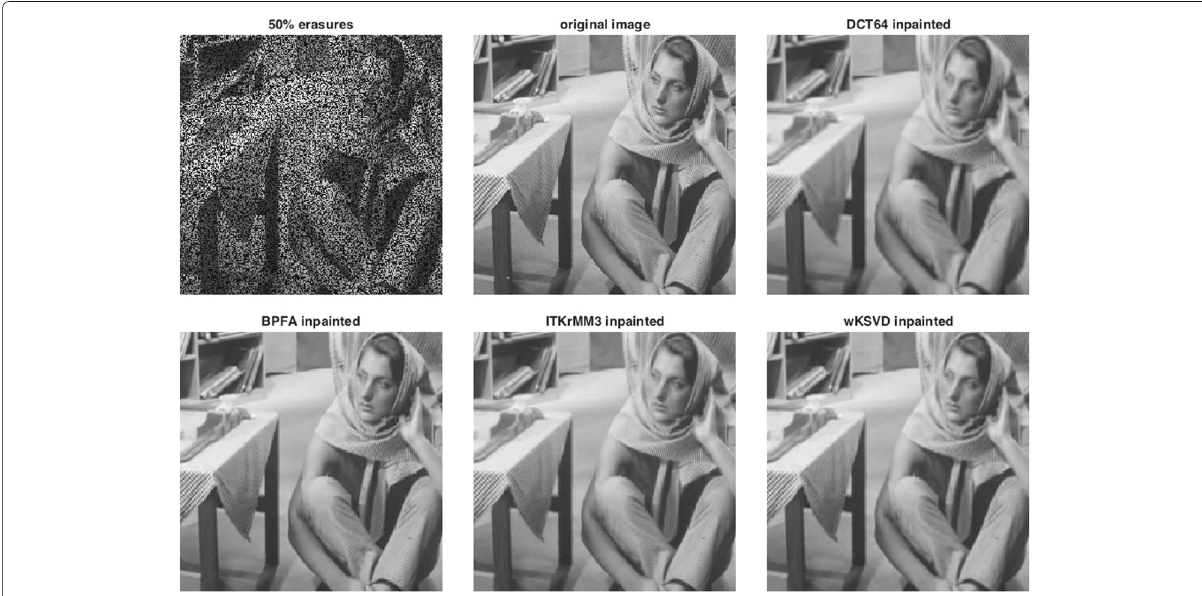
Fig. 9 Inpainting example: Barbara. Top row, left to right: image with 50% erasures, original image and reconstruction based on the DCT basis. Bottom row, left to right, reconstruction based on dictionaries learned by BPFA, ITKrMM ( L = 3) and